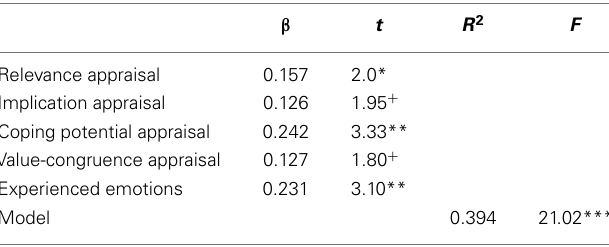
Table 4 | Regression results for the appraisal–emotion variables to predict intentions to engage in energy-saving behavior ( N = 168) .